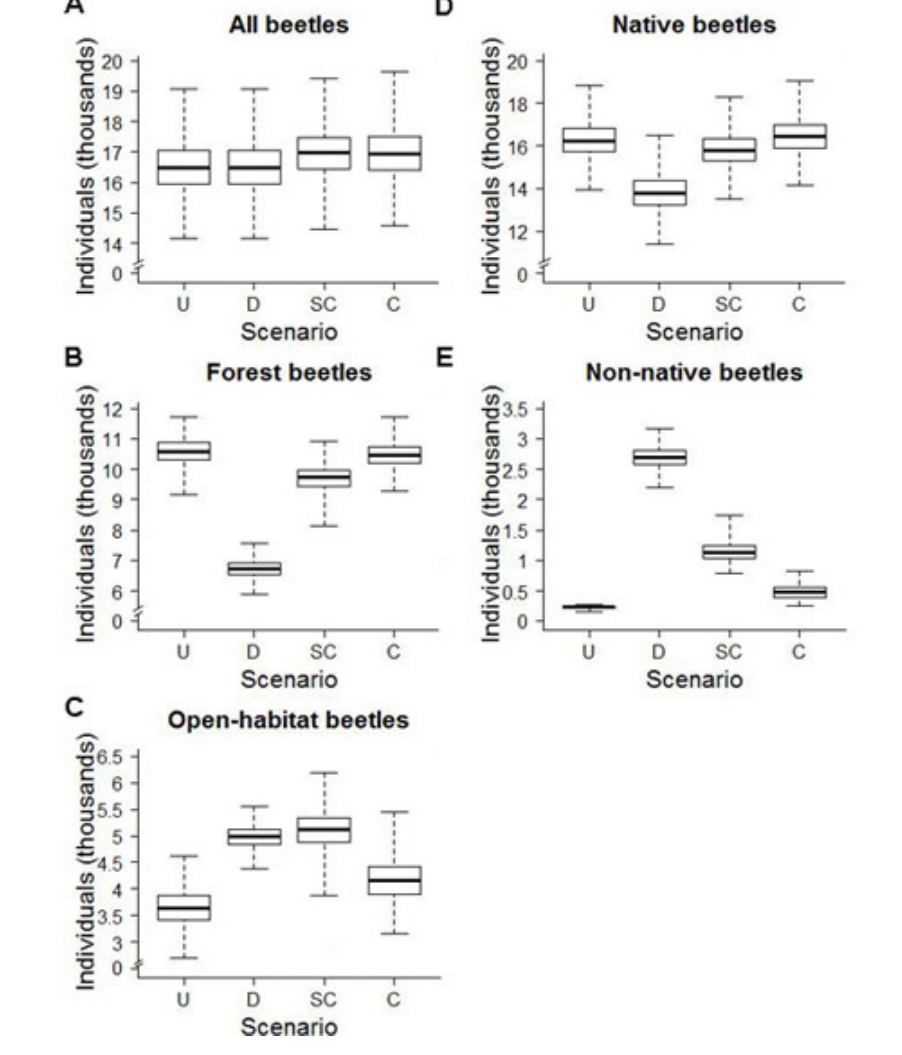
Fig. 5 . The estimated abundances of five carabid beetle groups in four hypothetical development scenarios: U, Undeveloped; D, Dispersed; SC, Semi-compact; C, Compact. (A) All beetles. (B) Forest beetles. (C) Open-habitat beetles. (D) Native beetles. (E) Non-native beetles. The species included in each group are given in Appendix 2. The lower edge of each box is the first quartile, the bold center line is the median, and the upper edge is the third quartile of the distribution. Whiskers extend to the minimum and maximum